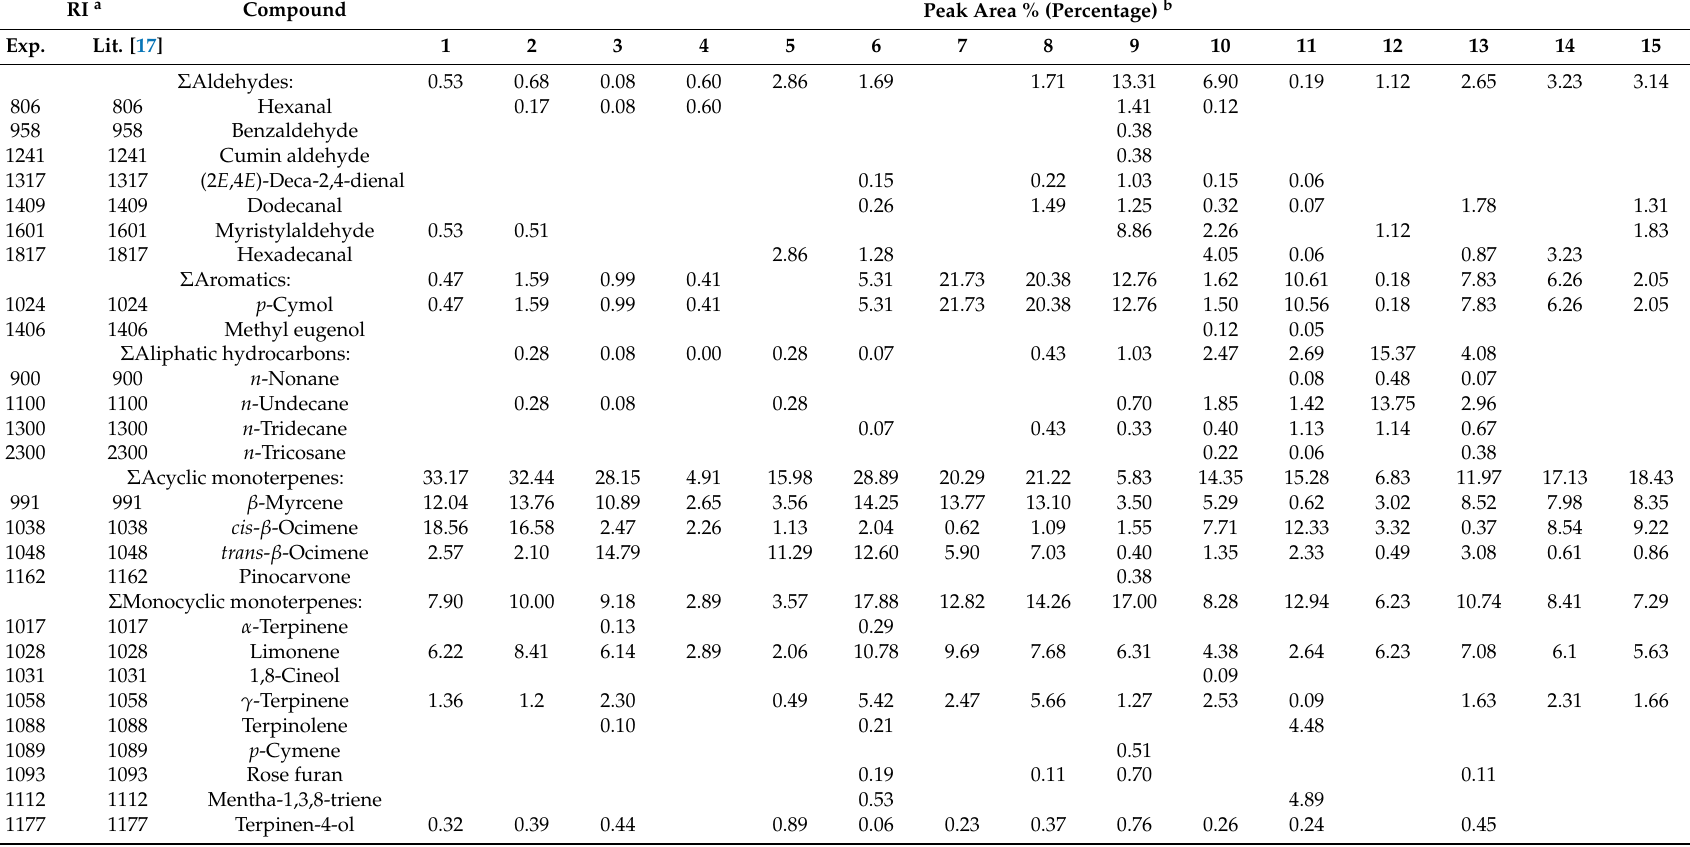
Table 1. Chemical composition of essential oils extracted from the aerial parts of Bupleurum scorzonerifolium Willd. from different countries or regions. RI a Compound Peak Area % (Percentage) b